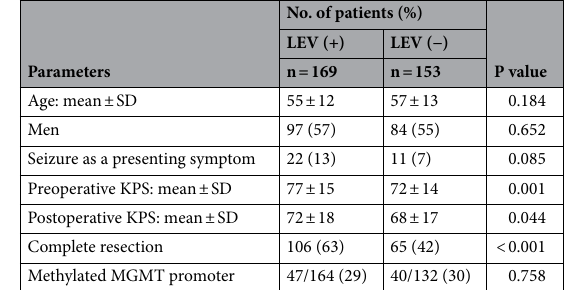
Table 2. Patient demographics according to the use of levetiracetam. LEV levetiracetam, SD standard deviation, KPS Karnofsky Performance Status, MGMT O 6 -methylguanine-DNA methyltransferase.